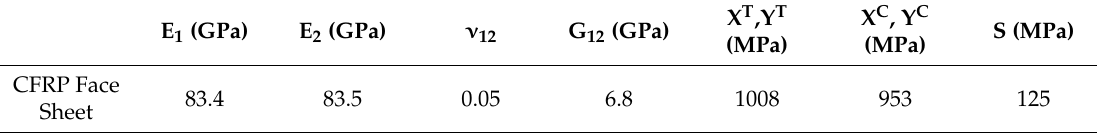
Table 3. Mechanical properties of the carbon fiber reinforced plastic (CFRP) composite.